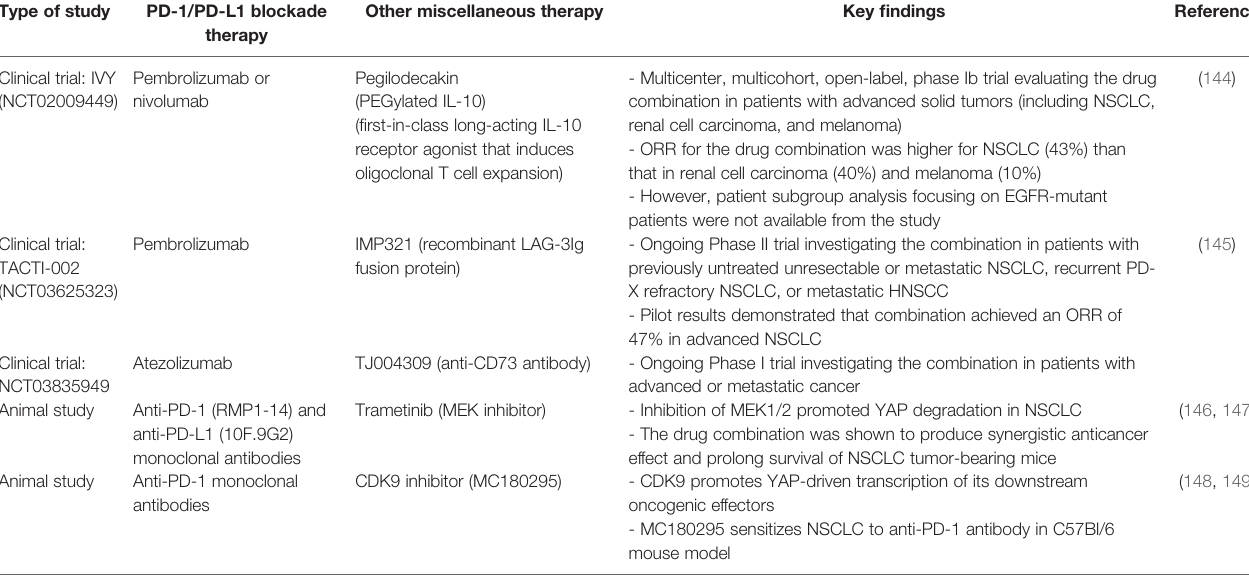
TABLE 5 | Representative studies (clinical trials and animal studies) evaluating the combination of PD-1/PD-L1 blockade immunotherapy and other miscellaneous therapies in EGFR-mutant